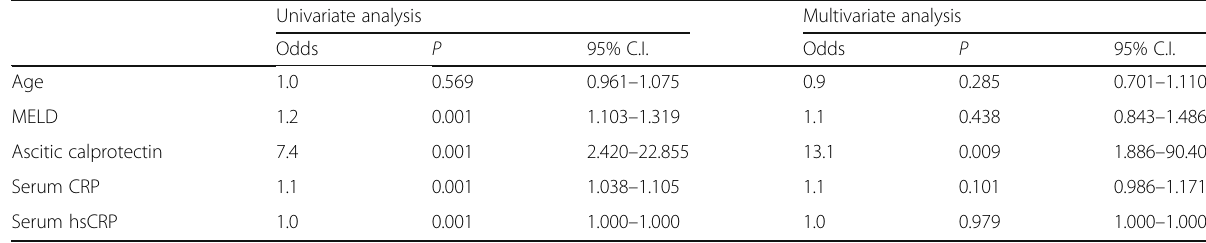
Table 3 Independent predictors of